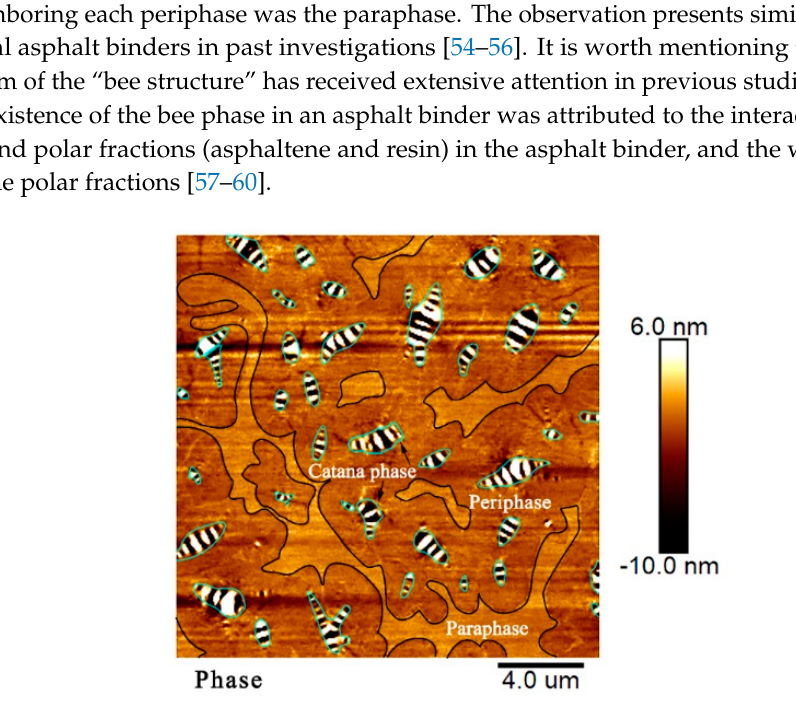
Figure 6. Interfacial morphology of the asphalt mastics. ( a ) GAM (5000×); ( b ) DAM (2000×); ( c ) LAM (2000×).